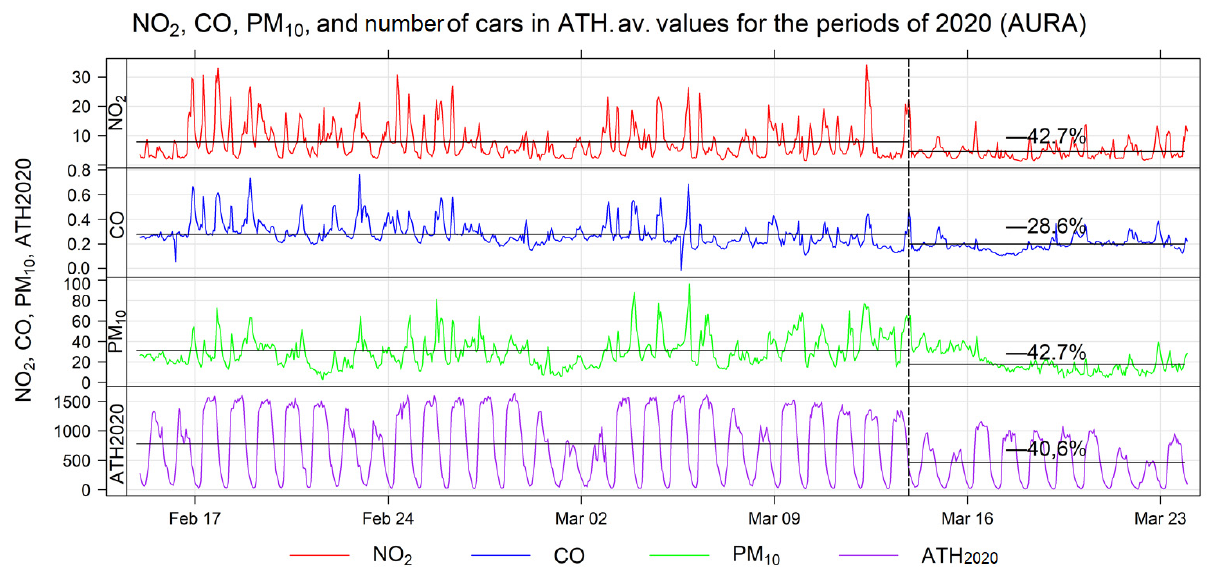
Figure 5. The hourly concentration variations of NO 2 (first row), CO (second row), PM 10 (third row) and vehicles (forth row) in Athalassis Avenue from P1/2020 (before lockdown) until the P2a/2020 (beginning of lockdown); black line denotes the period mean concentration value as calculated in Table